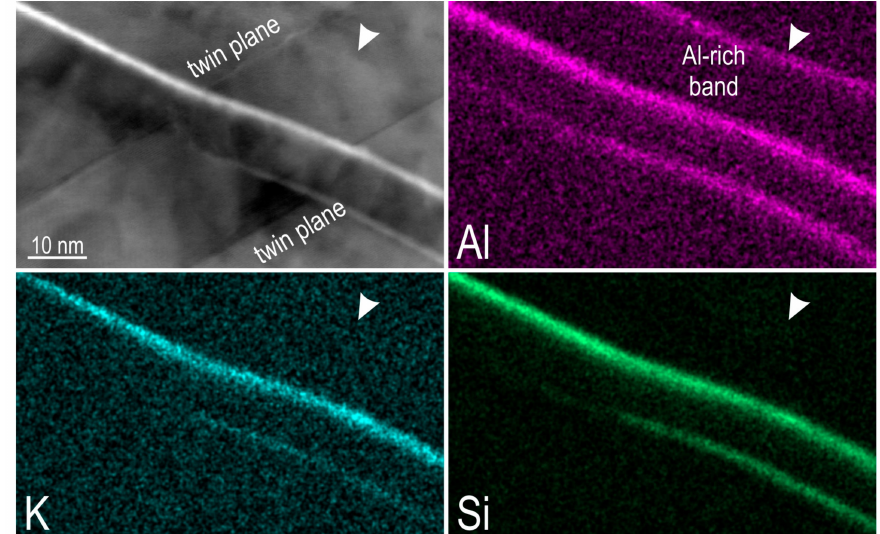
Figure 12. Bright field STEM image (top left) and STEM EDX maps of the Si-Al-K-bearing planes crosscutting twins at the upper part of foil #4. Note some of the planes are only depicted by Al